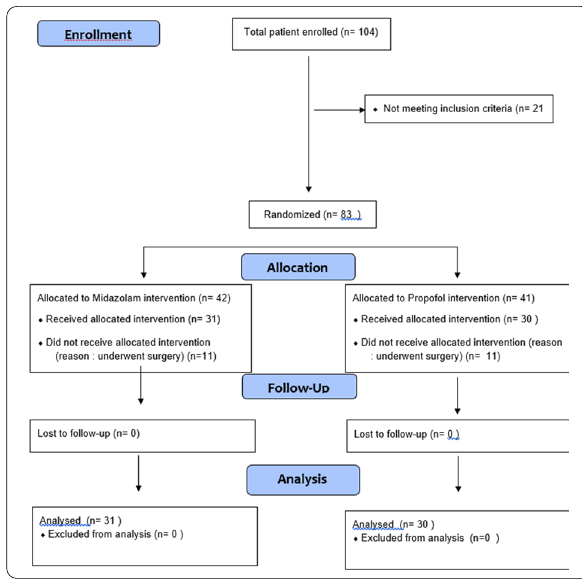
Table 2: Shows the initial and 48 h cortisol levels, hemodynamic vari- ables and ONSD value between Propofol and Midazolam group.